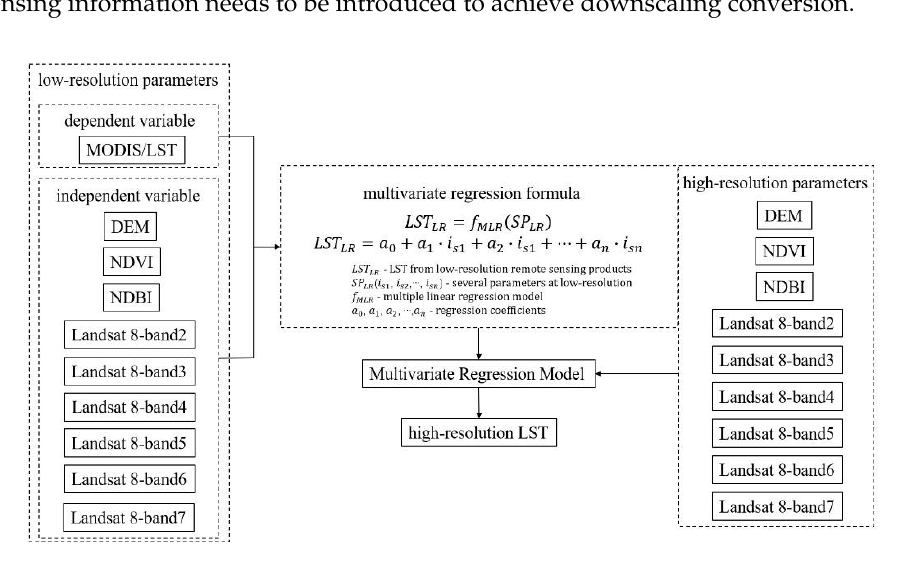
Figure 2. Building process of the multiple linear regression (MLR) model.